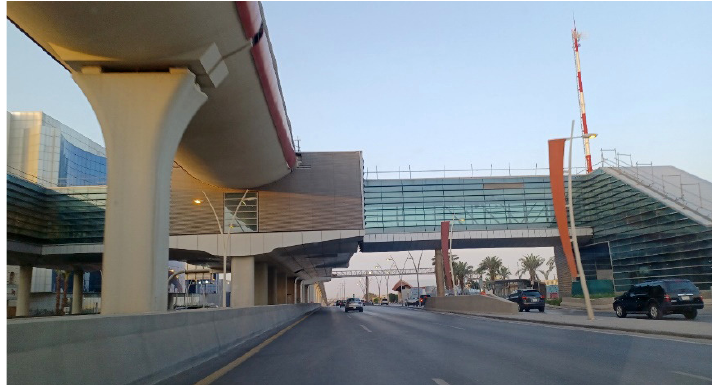
Figure 6. The Riyadh Metro project: Work in progress, pedestrian bridge for the metro